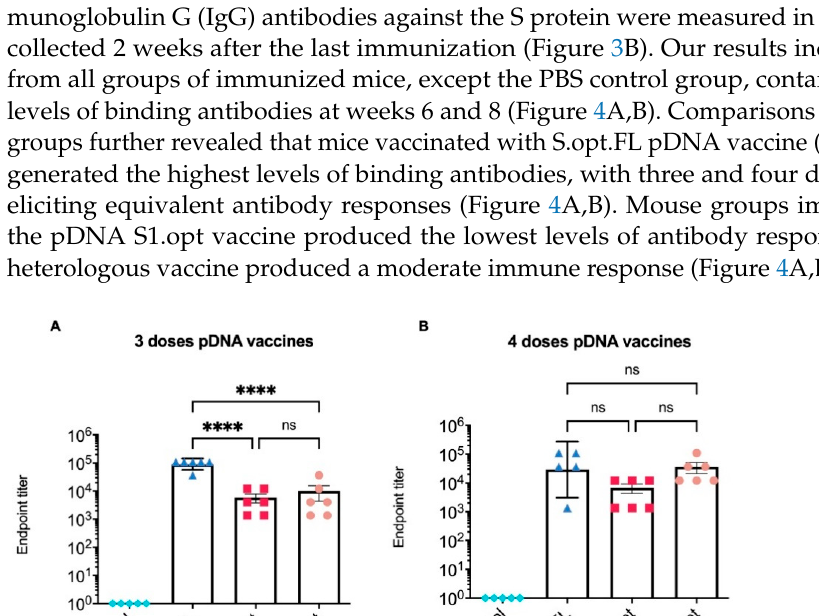
Figure 3. Schematic of the C57BL/6 mice immunization with SARS-CoV-2 vaccines. ( A ) Immunization groups and doses for the plasmid (p)DNA vaccines. All immunizations were received intramuscularly with 100 ug per dose, except the phosphate-buffered saline (PBS) control group. ( B ) The bleeding and immunization regime for the C57BL/6 mice.